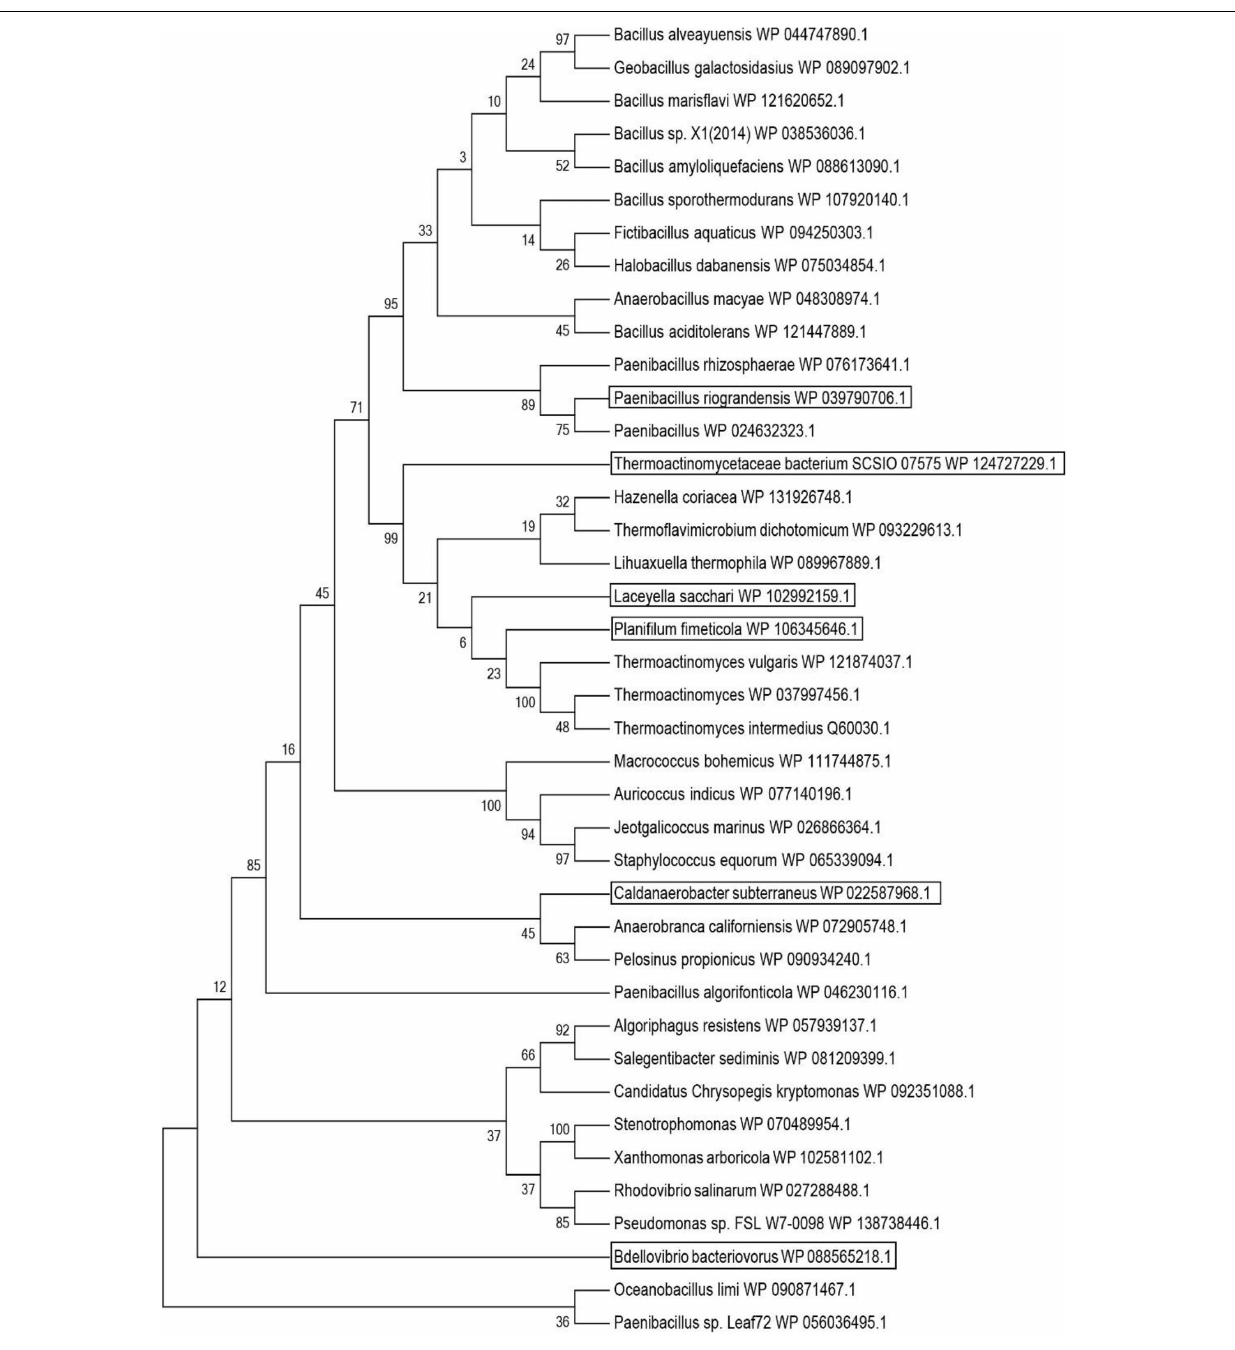
is collected and saved. It is concentrated and imidazole was removed by